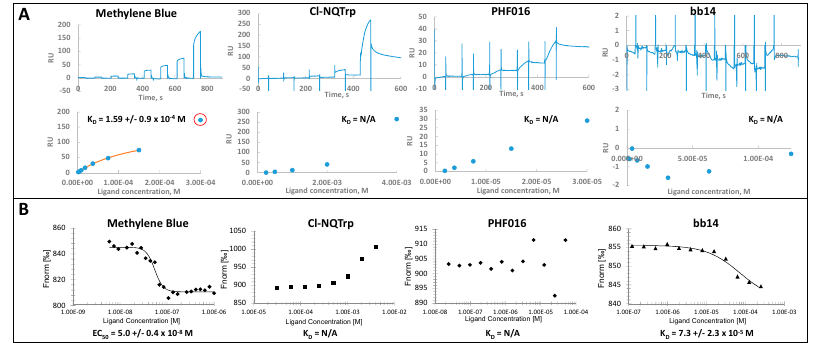
Figure 2. Surface plasmon resonance (SPR) and microscale thermophoresis (MST) techniques were used to assess ligand binding to tau K18 M . ( A ) Kinetic SPR binding curves and steady-state affinity graphs for Methylene Blue, Cl-NQTrp, PHF016 and bb14 with calculated K D values. Red-circled data point marks excluded data. Immobilization level: 1000 RU of biotinylated AviTag-tau K18 M . ( B ) Methylene Blue, Cl-NQTrp, PHF016 and bb14 MST dose–response data with assessed K D or EC 50 values to tau K18 M